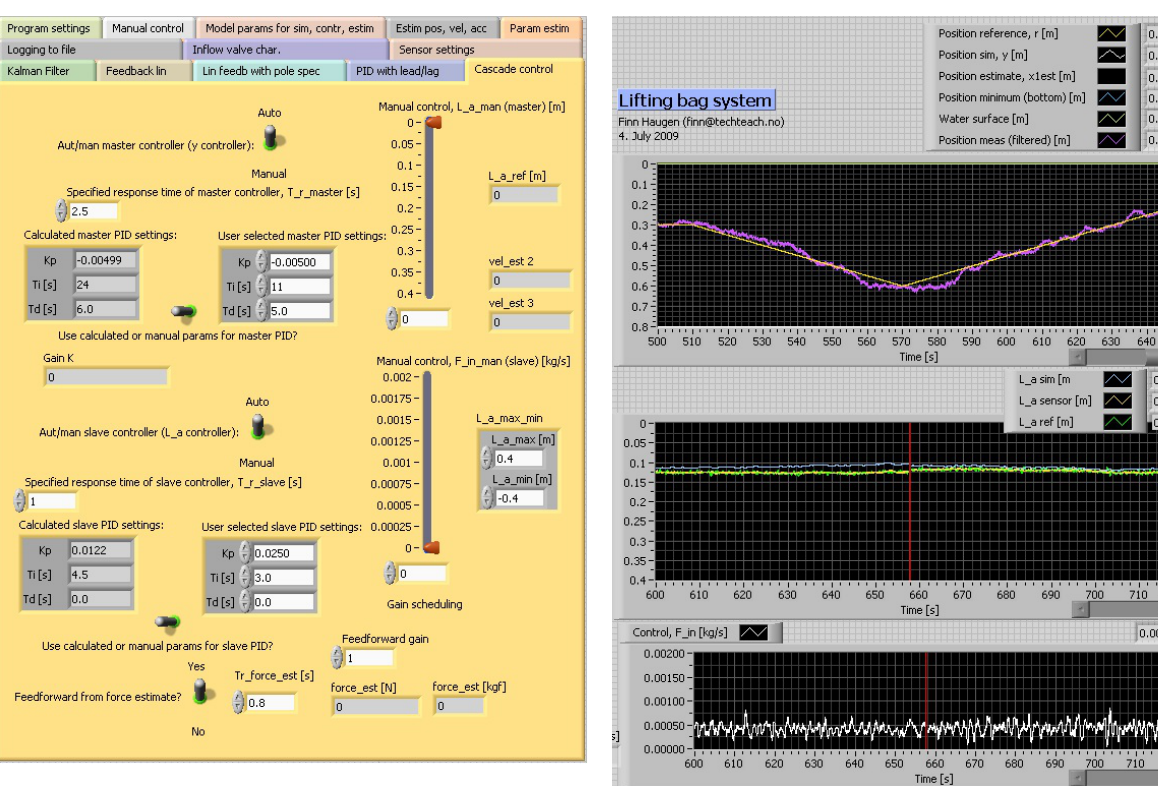
mated load force: Ramped changes of the po- sition